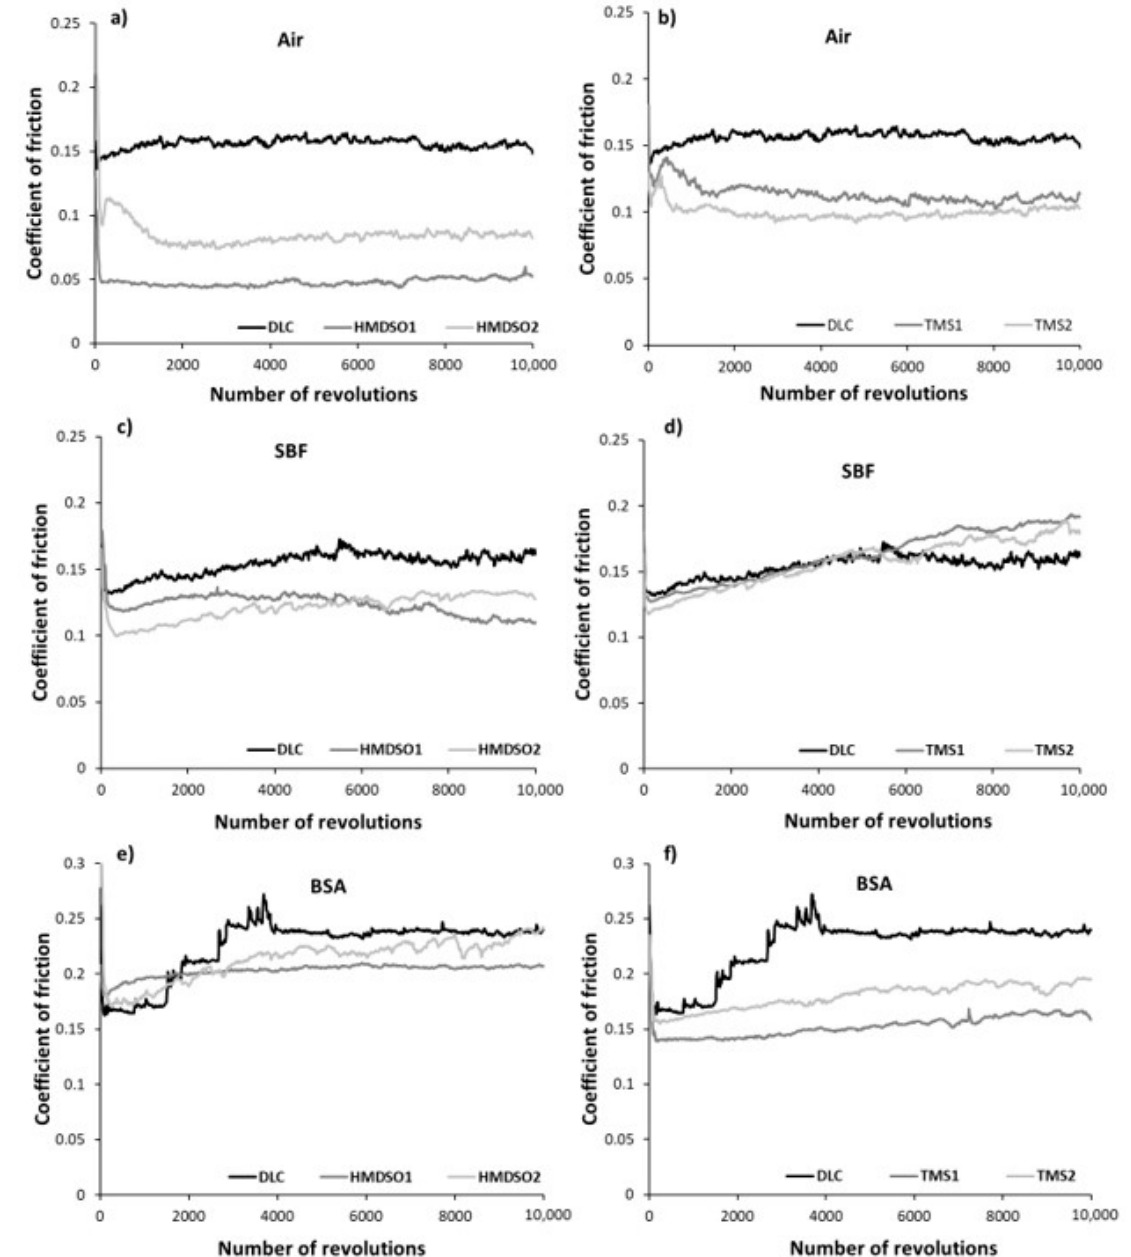
Figure 2. Friction coefficient evolution of DLC and silicon-incorporated DLC coatings synthesized using both HMDSO (left column) and TMS (right column) tested in ( a , b ) air, ( c , d ) SBF, and ( e , f ) BSA, respectively.